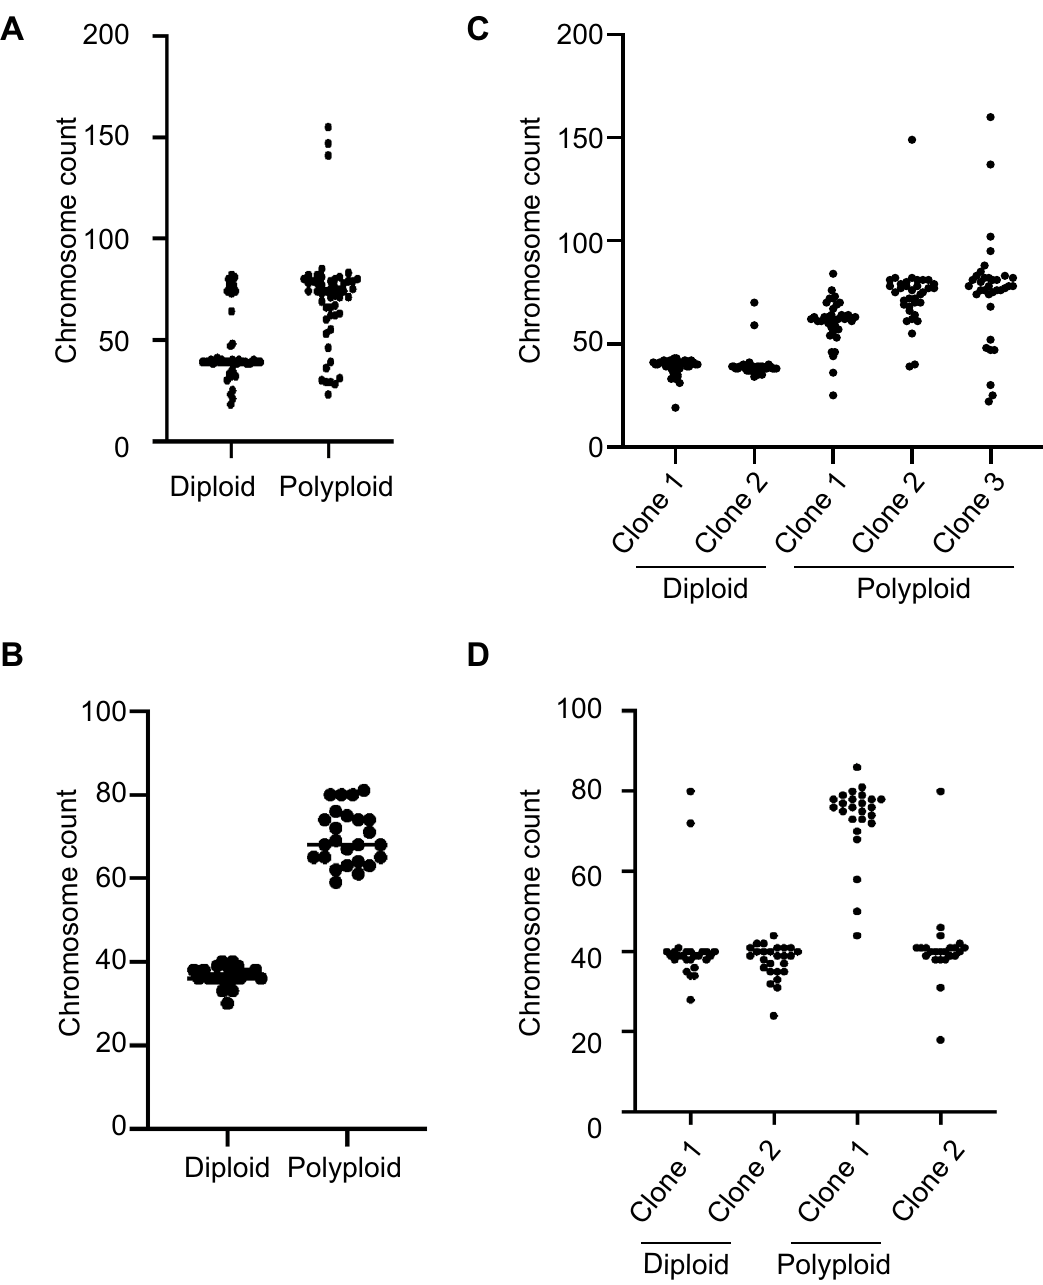
Figure 3. Tetraploid cells exhibit increased rates of chromosomal instability. ( A ) Chromosome counts in sorted diploid and tetraploid cells from the spontaneous model. Bars indicate the median cell count. Differences in variance between diploid and tetraploid cells was determined using an F-test for variance, p = 0.0073. ( B ) Chromosome counts in sorted diploid and tetraploid cells from the induced model. Bars indicate the median cell count. Differences in variance between diploid and tetraploid cells was determined using an F-test for variance, p < 0.0001. ( C ) Chromosome counts in single-cell clones derived from diploid or tetraploid cells from the spontaneous model (n = 35). ( D ) Chromosome counts in single-cell clones derived from diploid or tetraploid cells from the induced model (n = 25). ( A – D ) were generated using Graph Pad Prism 9 software (version 9.0.0 (86) for Mac, https:// www. graph pad. com/ scien tific- softw are/